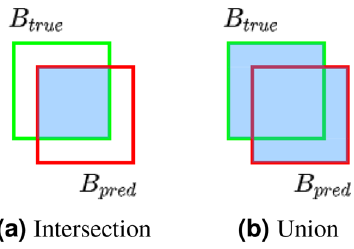
Figure 2. Bounding rectangle overlap of true and predicted defect